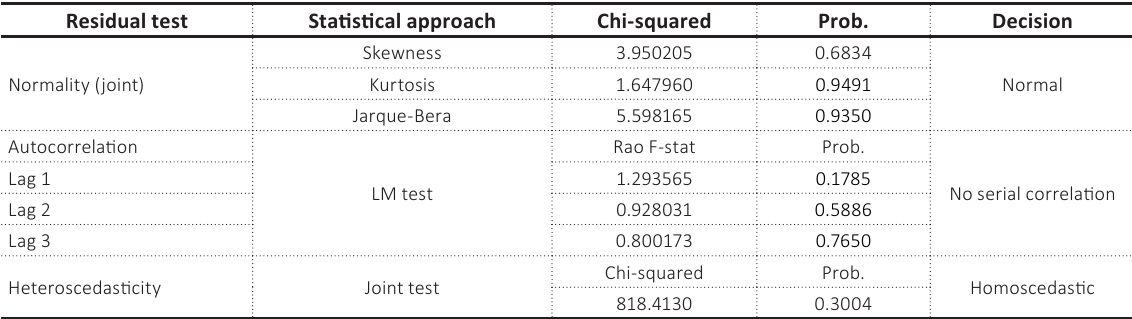
Table 5. VEC residual